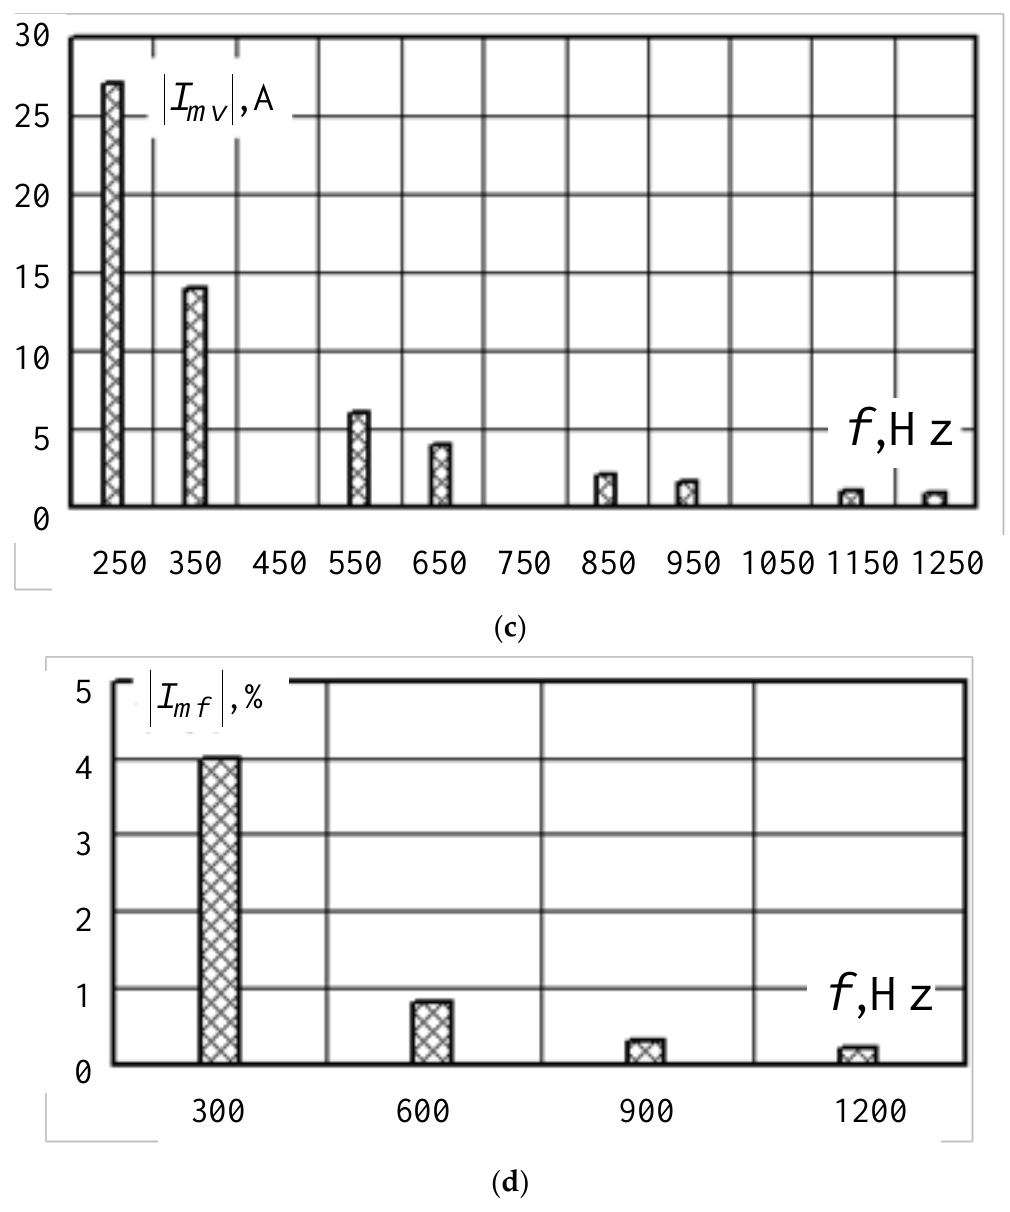
Figure 10. Waveforms of stator currents ( a ) and rotor currents ( b ) of the generator and their harmonic content ( c , d ) at Ua k =15.6%.